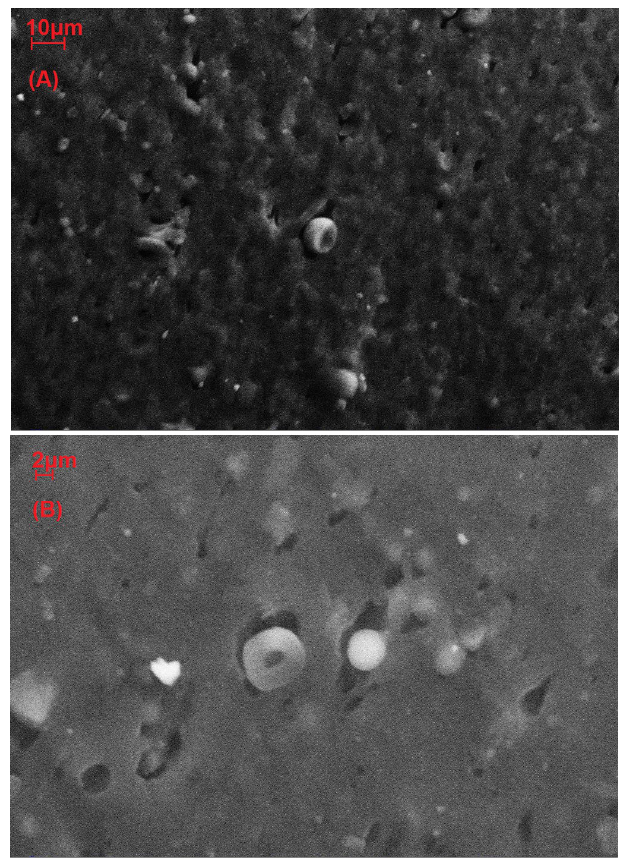
Figure 7. Scanning electron microscope image of wheat gluten plasticized with 35% of 1,4-butanediol and 20 php of microalgal biomass, magnifications 2000× ( A ) and 5000× ( B ). Figure 6 shows that the biomass particles were rounded with a size distribution of bigger particles, about 2–3 μm of diameter, and some smaller that were not visible. Some voids were present, showing that the adhesion of the larger particles to the gluten matrix seemed rather limited.